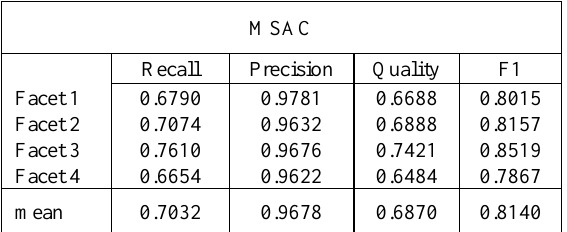
Table 4 . Evaluation metrics for MSAC